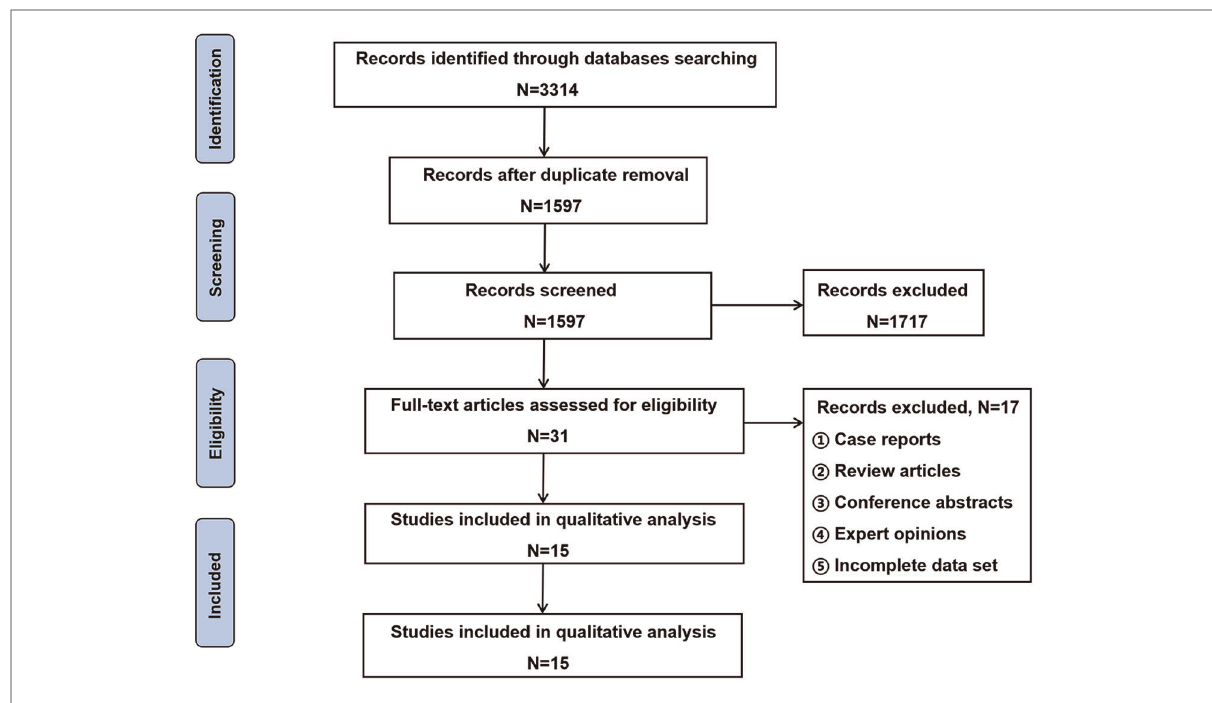
FIGURE 1 Preferred reporting items for systematic